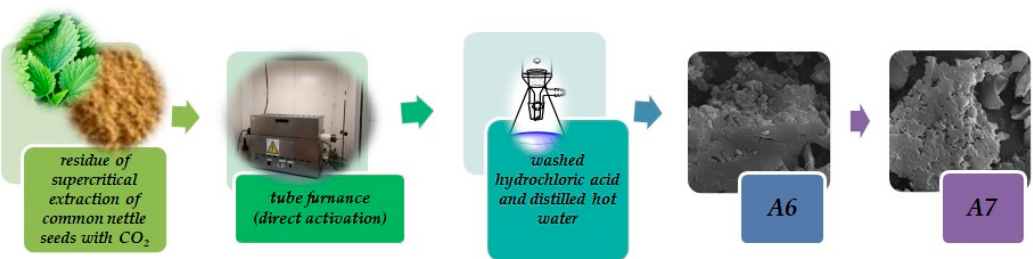
Figure 1. Scheme of biochar preparation.